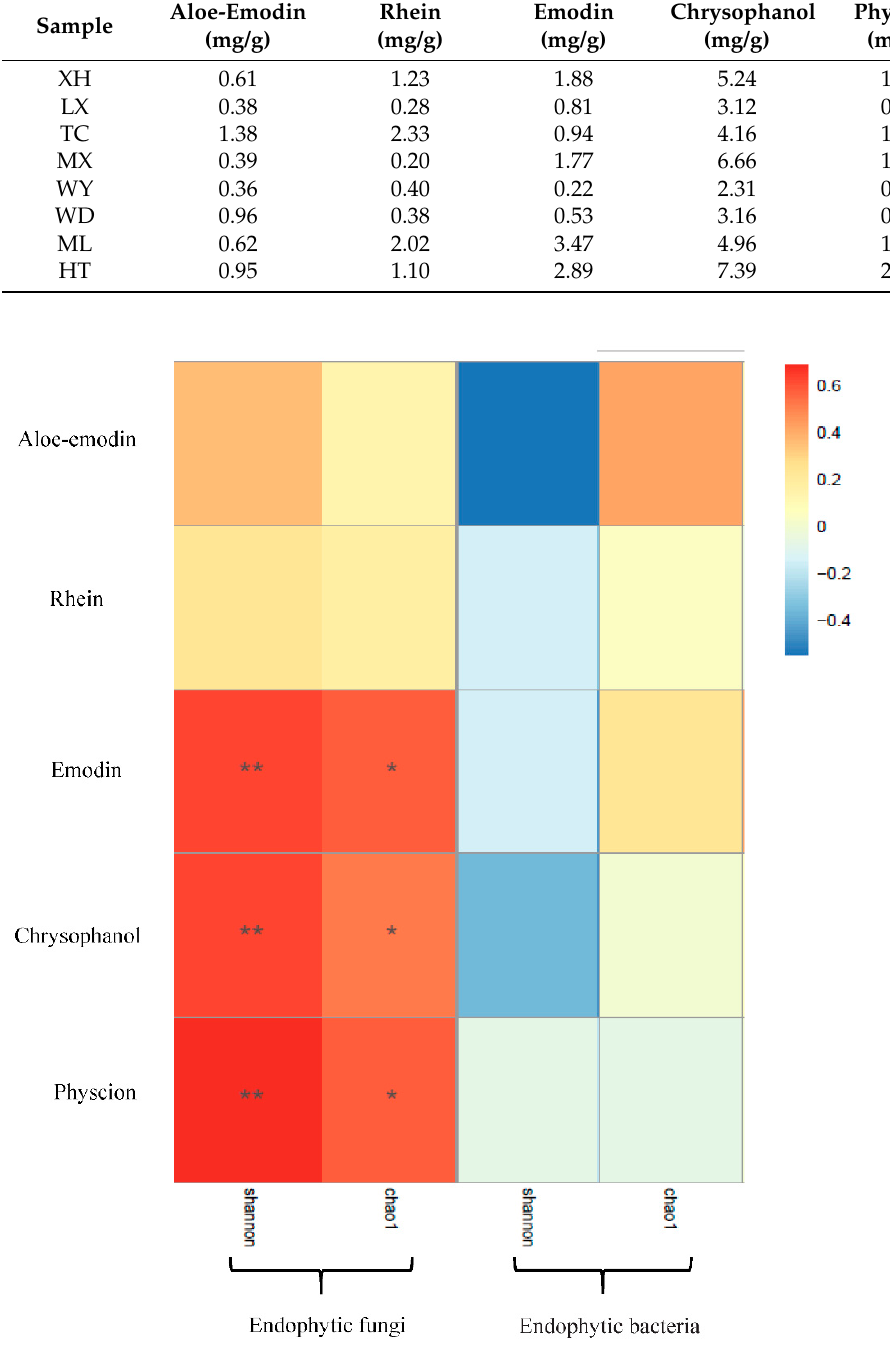
Figure 7. Correlation analysis between metabolites and diversity of endophytes. Note: * indicate the differences are significant at p < 0.05 and ** indicate the differences are significant at p <